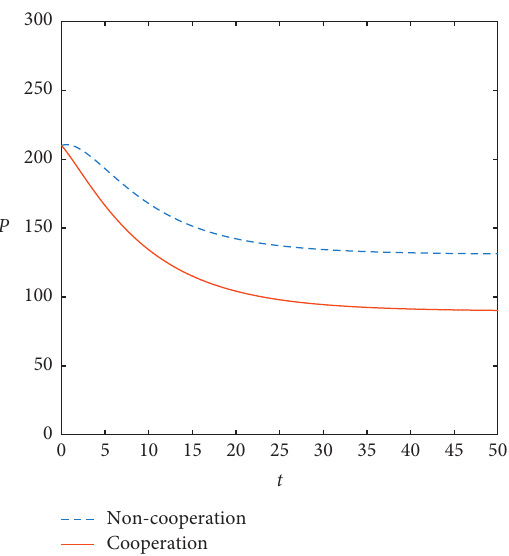
Figure 18: Optimal trajectory of pollution stock under cooperation and non-cooperation when the planning period T ⟶ ∞